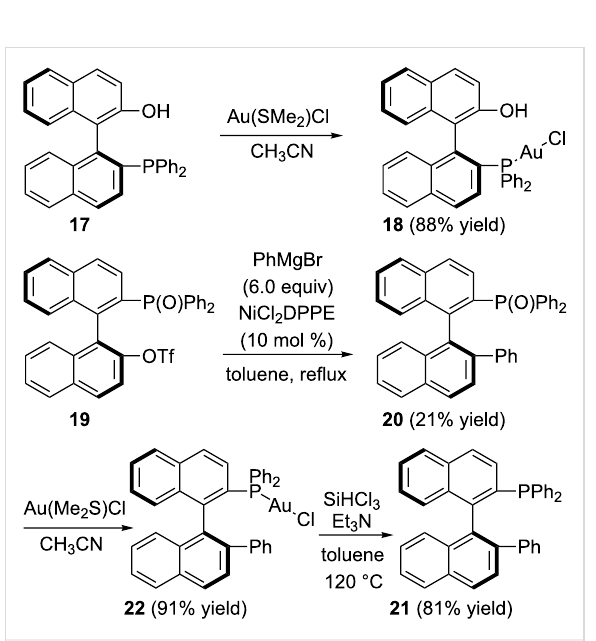
Scheme 6: The synthesis of P–Au complexes.